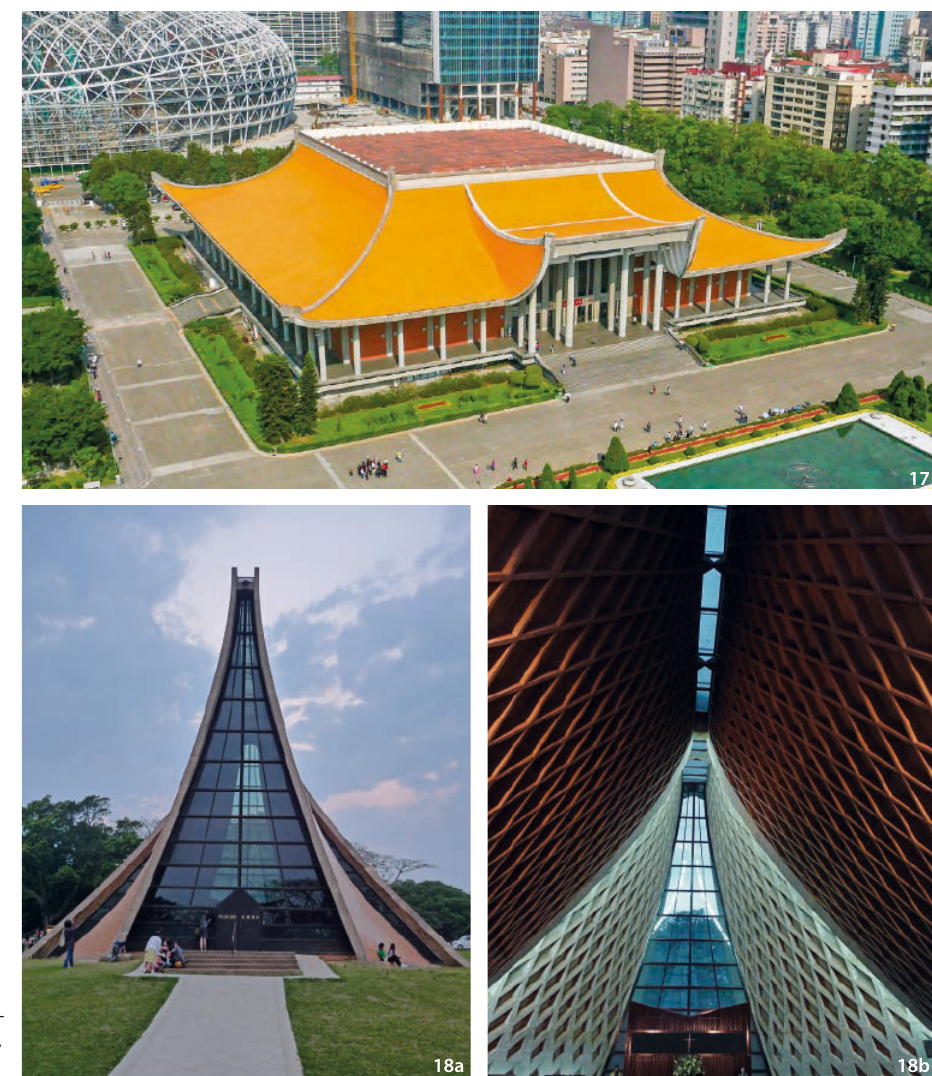
Figure 17 Sun Yat Sen Me- morial Hall in Taipei, 1972 (Source: https://museums. moc.gov.tw/MusData/ Detail?museumsId=01cb6413- a591-4613-802b-5e3d- 898250cd). Figure 18a and 18b Luce Memo- rial Chapel in Tunghai University, 1963 (Source: Qing